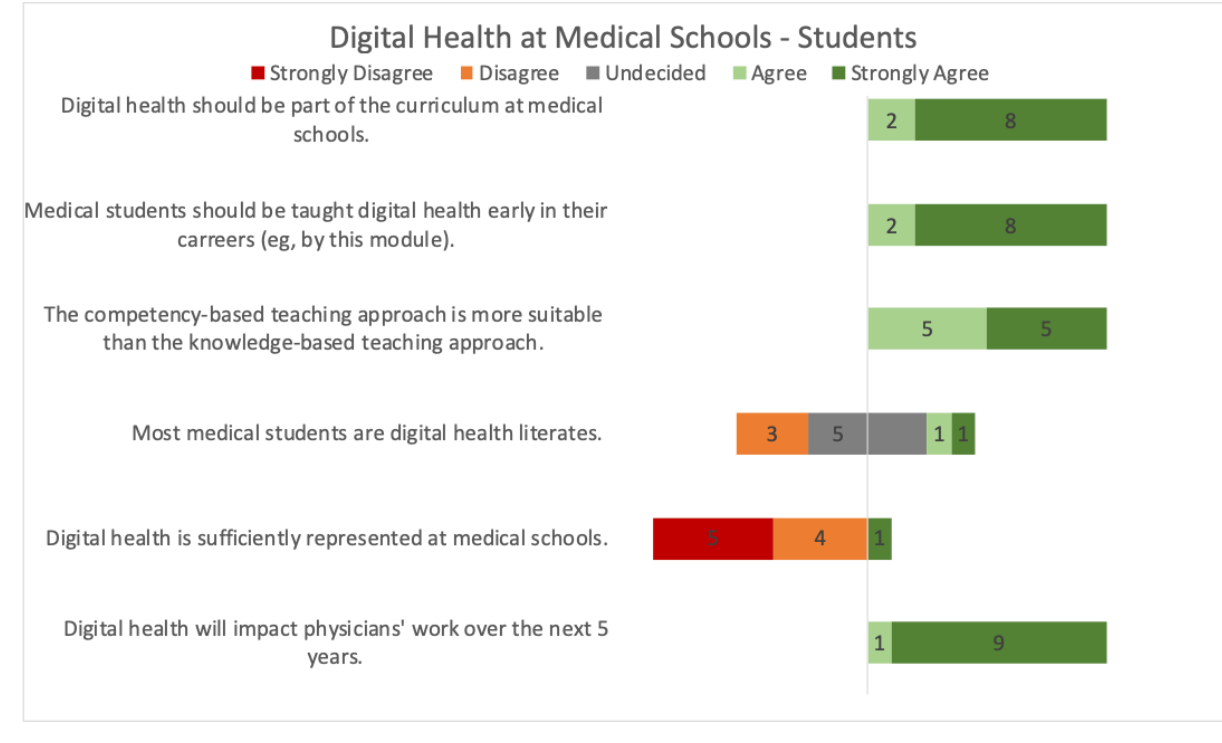
Figure 2. Students’opinions regarding digital health at medical schools.